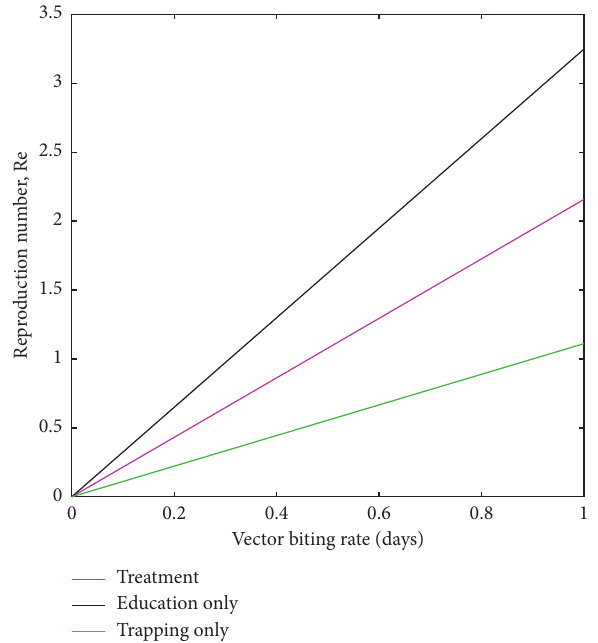
Figure 10: Effects of single intervention on effective reproduction number with respect to vector biting rate.